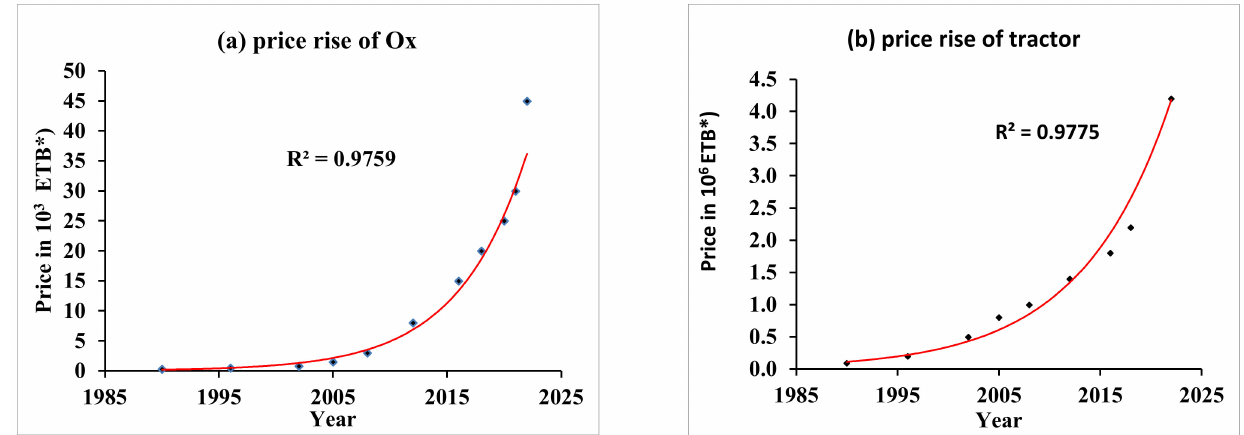
Figure 3. The increase prices of Ethiopian zebu (humped cattle) ox ( a ); and the increasing prices of Massey Ferguson Tractor in Ethiopia ( b ); * One US Dollar in 2022 is approximately 51 Ethiopian Birrs